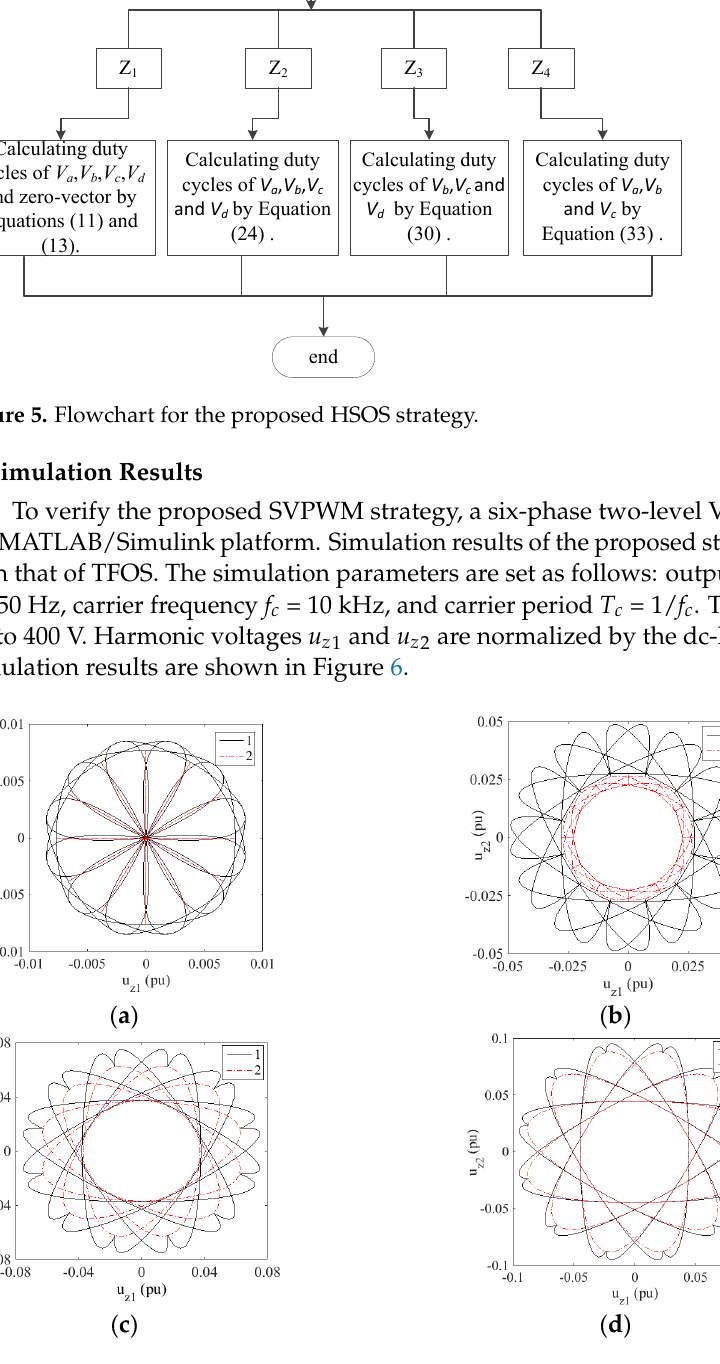
Figure 6. Simulated u Z 1 and u Z 2 trajectories results of two strategies in the Z 1 − Z 2 subspace. Here, 1 denotes the TFOS strategy, 2 denotes the proposed HSOS strategy: ( a ) m = 0.585; ( b ) m = 0.605; ( c ) m = 0.615; ( d ) m = 0.622.